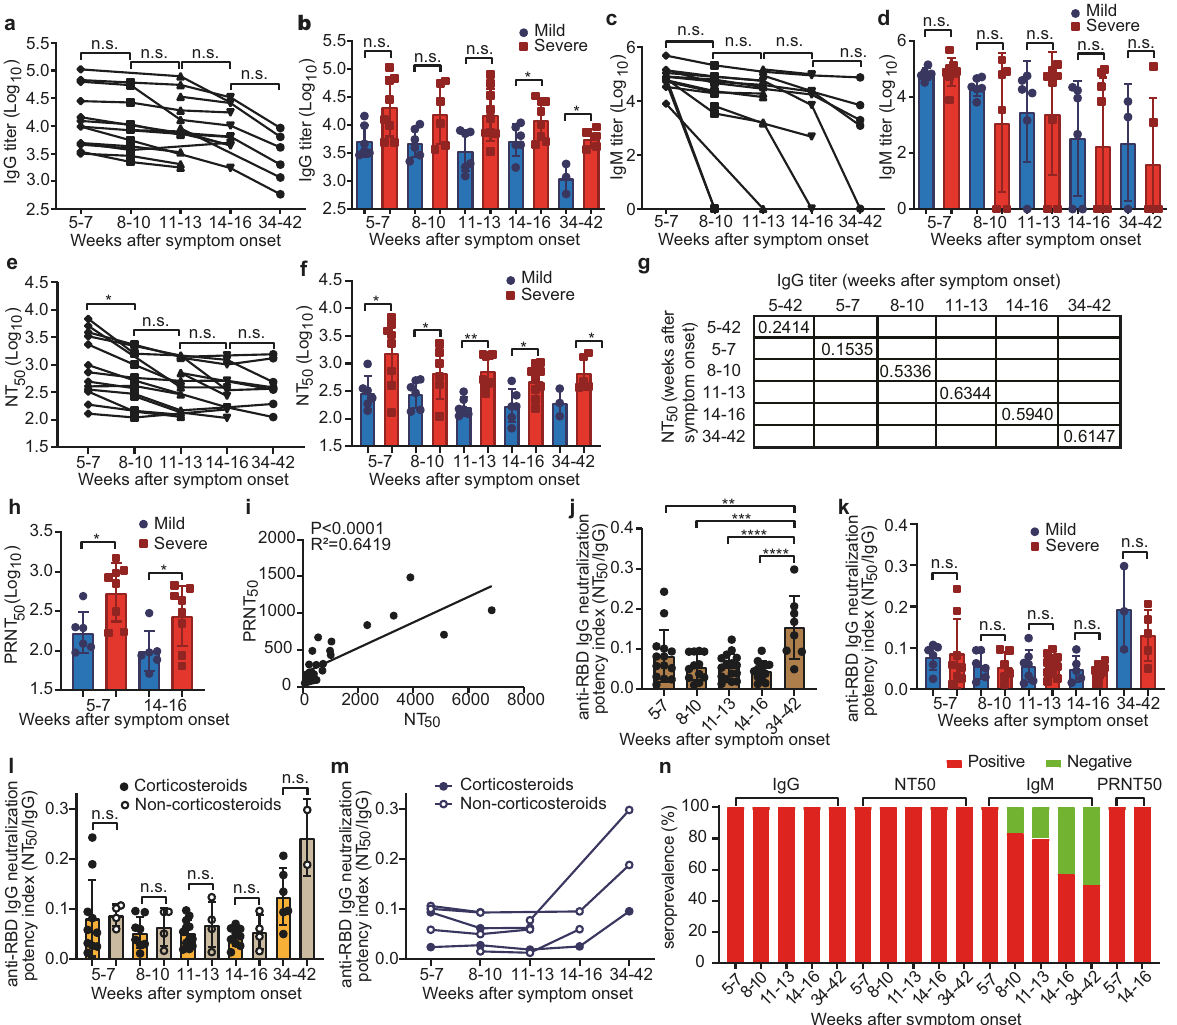
Fig. 1 Antibody responses against SARS-CoV-2 spike protein in COVID-19 recovered individuals. IgG ( a ), IgM ( c ), and NT 50 titers ( e ) against SARS- CoV-2 S-RBD or S protein of the recovered patients from 5 – 7 to 34 – 42 weeks ( n = 17). Comparison of the IgG ( b ), IgM ( d ), and NT 50 titers ( f ) between mild and severe patients from 5 – 7 to 34 – 42 weeks ( n = 24). g Correlation analysis of NT 50 titers and IgG titers of the recovered patients during 5 – 42, 5 – 7, 8 – 10, 11 – 13, 14 – 16, and 34 – 42 weeks. h Comparison of the PRNT 50 titers between mild and severe patients during 5 – 7 ( n = 14) and 14 – 16 ( n = 14) weeks. i Correlation analysis of NT 50 titers and PRNT 50 titers of the recovered patients during 5 – 16 weeks ( n = 28). Anti-RBD IgG neutralization potency index (NT 50 /IgG) was calculated ( j ) and compared between mild and severe patients ( k ) from 5 – 7 to 34 – 42 weeks ( n = 24). l Comparison of the anti-RBD IgG neutralization potency index (NT 50 /IgG) between the patients who treated with corticosteroids or not from 5 – 7 to 34 – 42 weeks ( n = 24). m The longitudinal dynamics of the anti-RBD IgG neutralization potency index (NT 50 /IgG) in mild patients who treated with corticosteroids or not ( n = 7). n Seroprevalence of the IgG, IgM, NT 50 , and PRNT 50 titers in patients from 5 – 7 to 34 – 42 weeks after symptom onset (5 – 7, n = 14; 8 – 10, n = 12; 11 – 13, n = 17; 14 – 16, n = 10; 34 – 42, n = 8). n.s., not signi fi cant; * P <0.05; ** P <0.01; *** P <0.001; **** P <0.0001 fi nd that the strong correlation between IgG and neutralizing antibodies was appeared during 11 – 13 weeks, while the plasmablasts are no longer present in recovered individuals at ~1 month after symptom onset, 4 that on one hand it probably because of short-lived, low-af fi nity antibodies degraded later than plasmablasts disappeared, on the other hand, it possibly account for the time distance between plasmablasts disappeared and the germinal center generated high-af fi nity antibodies.